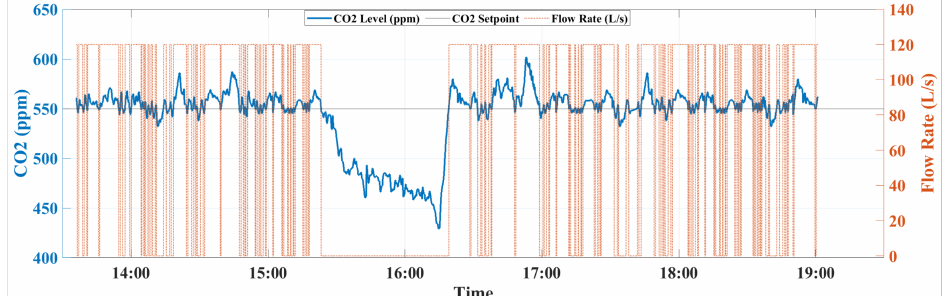
Figure 13. The ON/OFF flow rate output together with the CO 2 concentration variation.